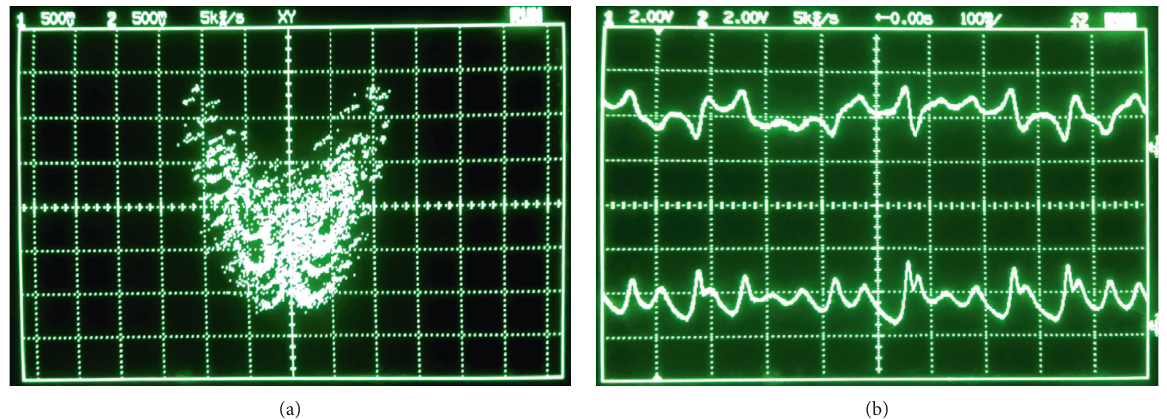
( n ) versus z ( n ) and (b) evolution of state